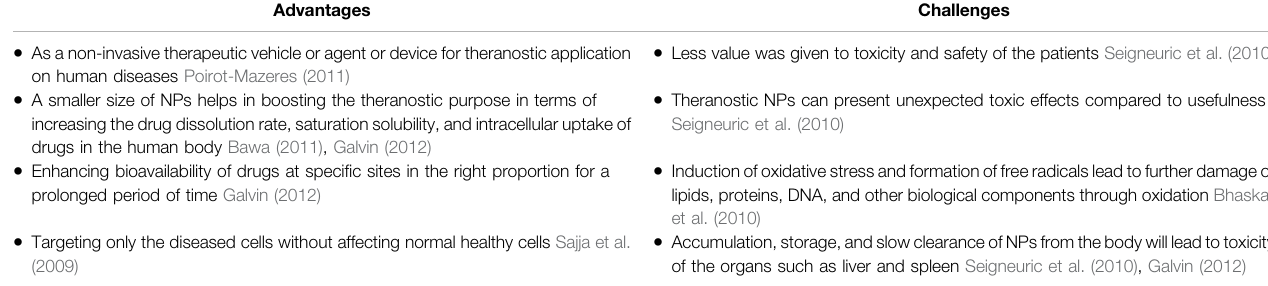
TABLE 2 | Advantages and challenges of nanoparticles to be translated into nanomedicine.